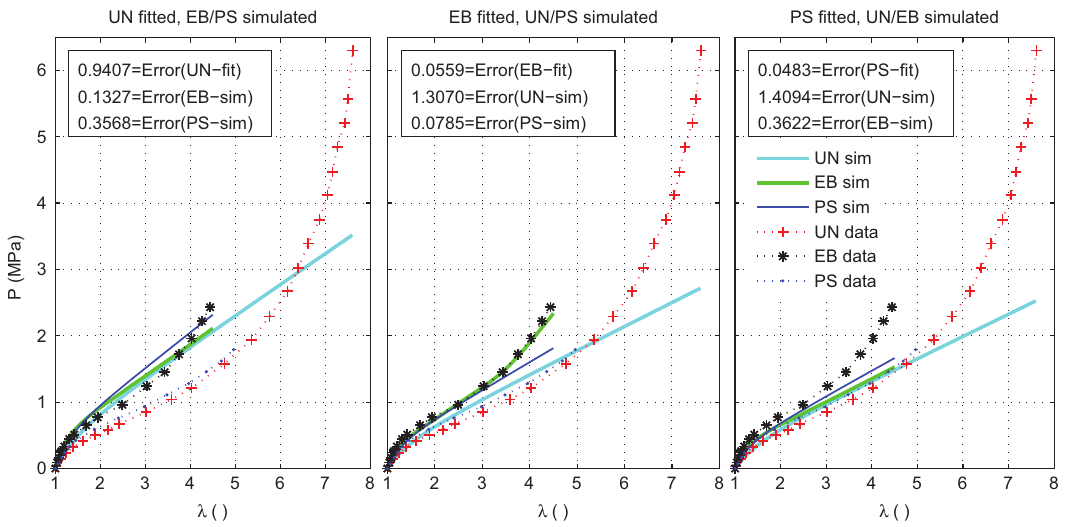
Figure 13 Performance of the Flory-Erman model on the Treloar data. Similar to the Neo-Hooke model, this model fails to capture the characteristic S shape.